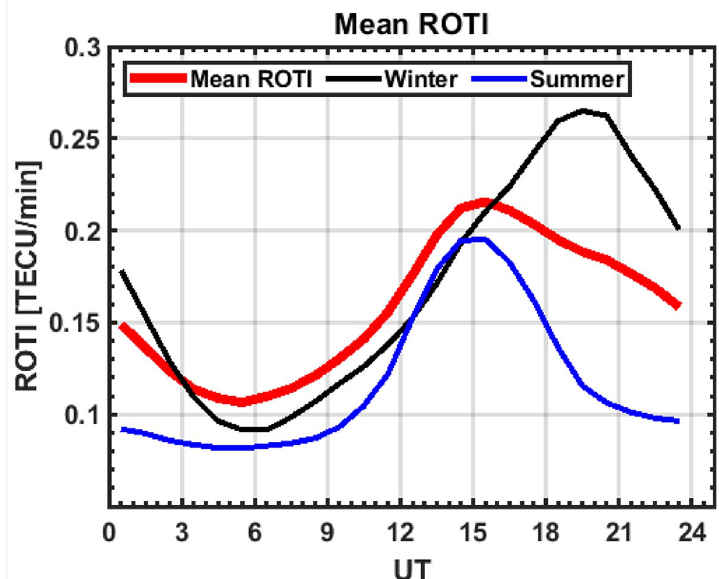
Fig. 5. The mean of ROTI data over all winter (November, December, and January) in black and summer (May, June, and July) months in blue. The mean ROTI over all seasons is also presented as a thick red line.